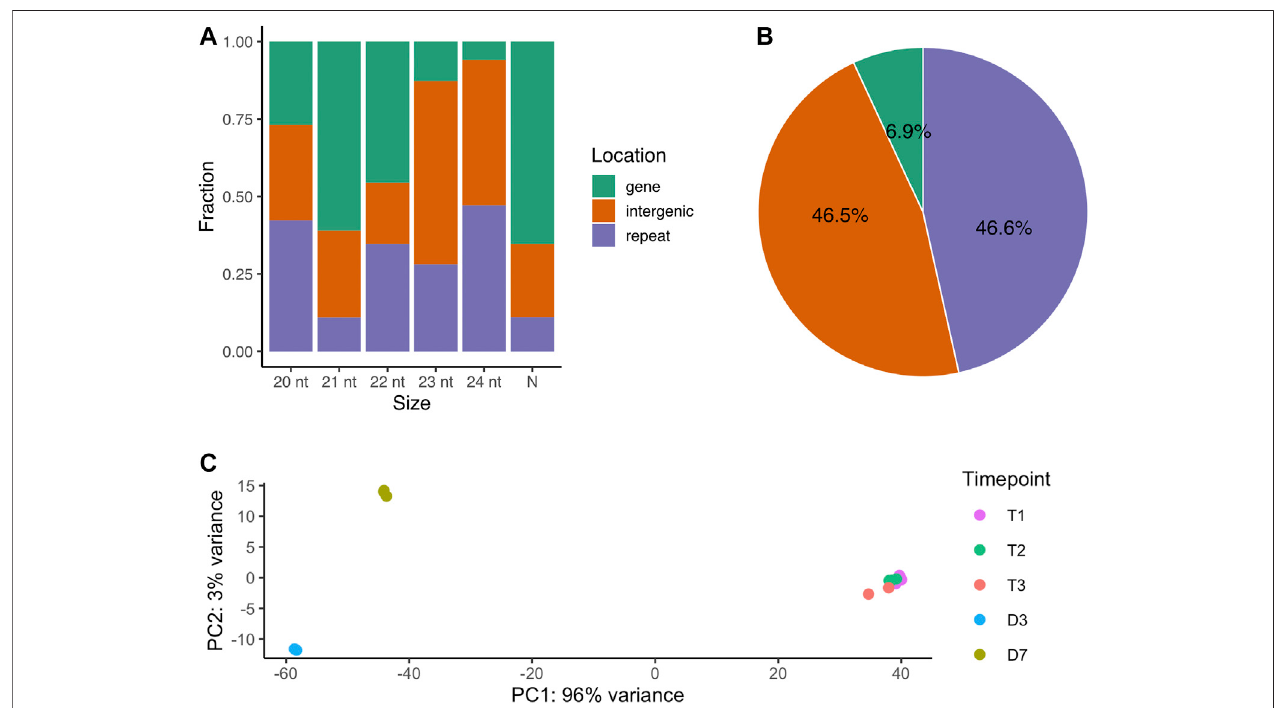
FIGURE 1 | The genomic origins of small RNA loci (A) The fraction of all small RNA loci located across genomic regions by major RNA size. N represents major RNAs that are either shorter or longer than 20-24 nt (B) The percentage of novel siRNA loci by genomic regions (C) PCA analysis of small RNA loci expression over dormancy progression. T1, 0 CH; T2, 500 CH; T3, 1000 CH; D3, day 3 of warm conditions; D7, day 7 of warm